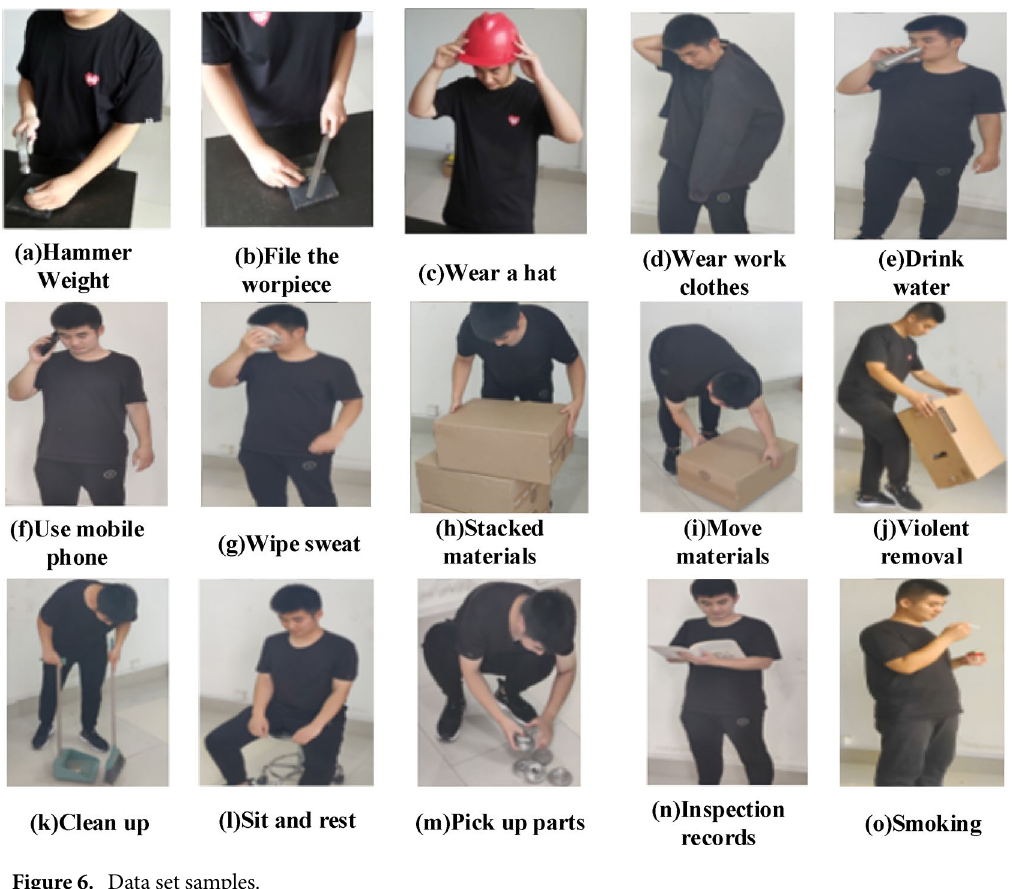
Figure 6. Data set